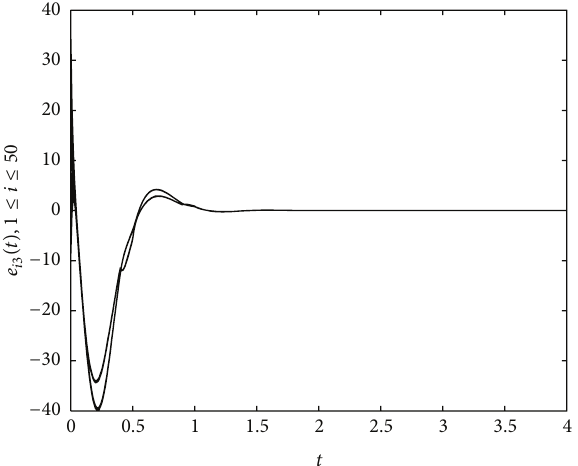
Figure 4: Synchronization errors 𝑒 𝑖 3 , 1 ≤ 𝑖 ≤ 50, with control parameters 𝑘 = 5, 𝑇 = 0 . 5, and 𝜃 = 0 . 8.